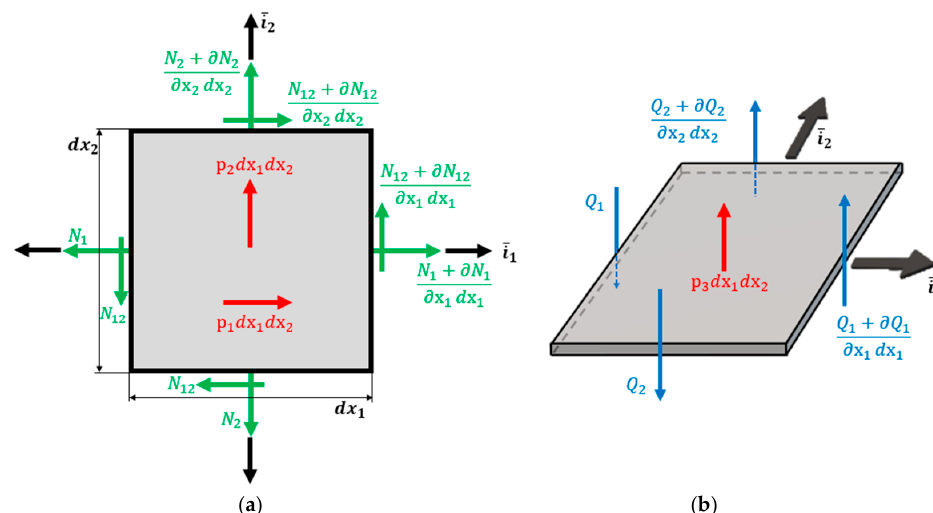
Figure 23. ( a ) Free body diagram for the equilibrium of in-plane forces and ( b ) free body diagram for the equilibrium of transverse shear